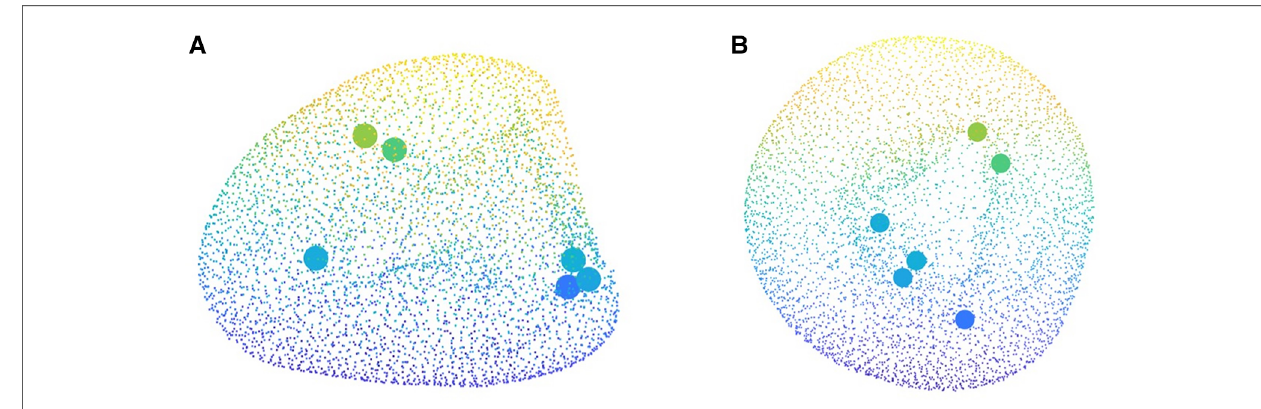
FIGURE 9 Critical points of heart contributing to the cardiac remodeling captured by the variable importance in projection (VIP) score which are all located on the internal wall of the left